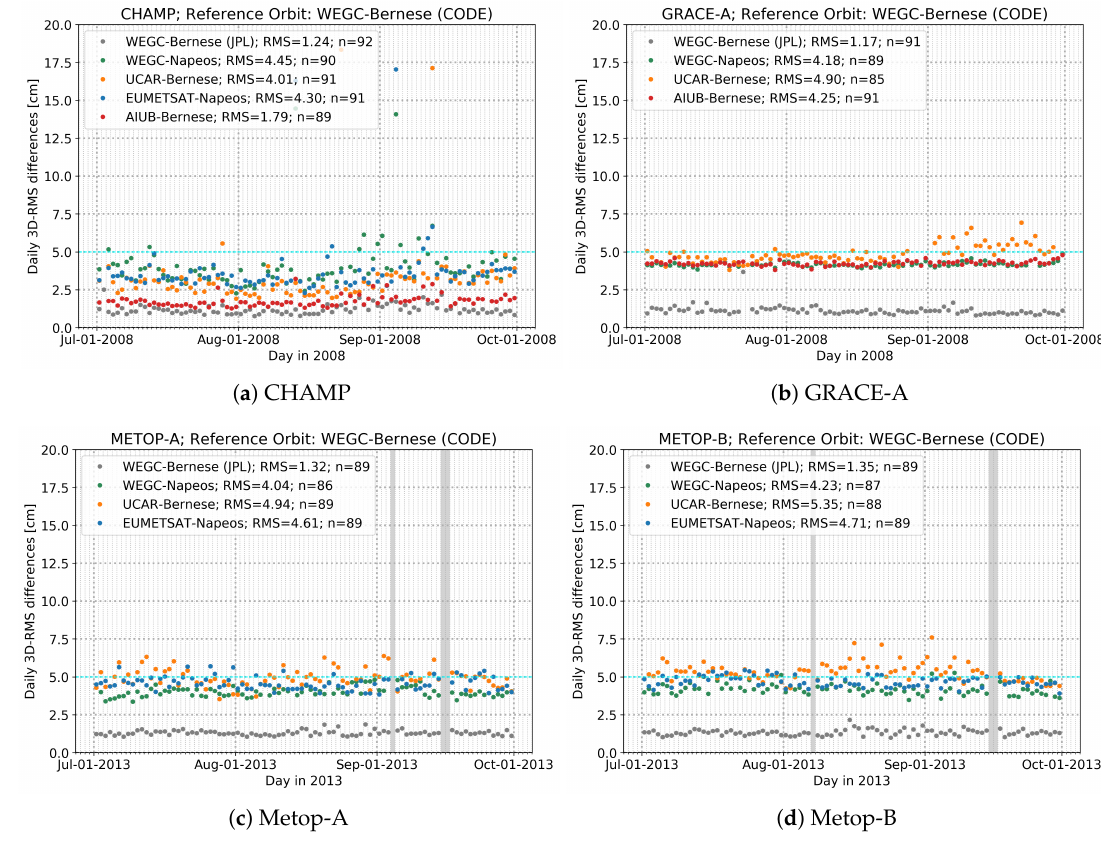
Figure 4. Daily 3D-root-mean-squared (RMS) orbit differences between the WEGC-Bernese (CODE) primary solution and WEGC-Bernese (JPL), WEGC-Napeos, UCAR, EUMETSAT, and AIUB orbit solutions for: ( a ) CHAMP and ( b ) GRACE-A from July to September 2008, and ( c ) Metop-A and ( d ) Metop-B for July to September 2013. Gray shading in the Metop-A/B panels indicates three excluded days where an orbit maneuver took place (Metop-A: 2013-09-04; Metop-B: 2013-08-07) or satellite attitude from CDAAC is missing (2013-09-15, 2013-09-16). Rare outliers exceeding 20 cm in 3D-RMS difference (10 days total for all four satellites) have been disregarded for the calculation of the overall RMS noted as part of the legend (in units cm). The number of total days included in the calculation for each orbit solution is denoted by